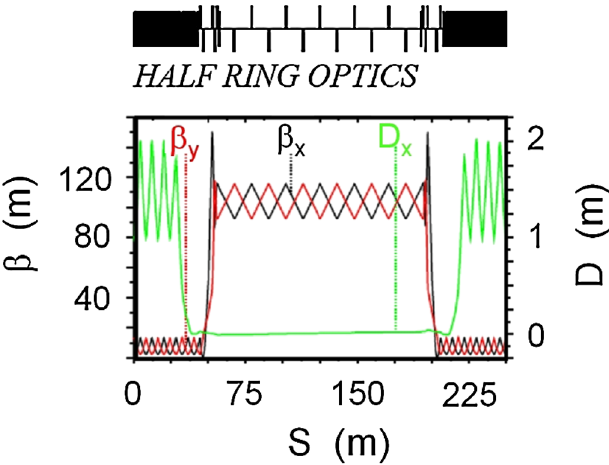
FIG. 16. (Color) Optical functions ð (cid:6) x ; (cid:6) y ; D x Þ for the half ring showing the beam-forming straight section between arc sections, and contrasting the weak-focusing straight sections with the stronger focusing arcs of the racetrack lattice.